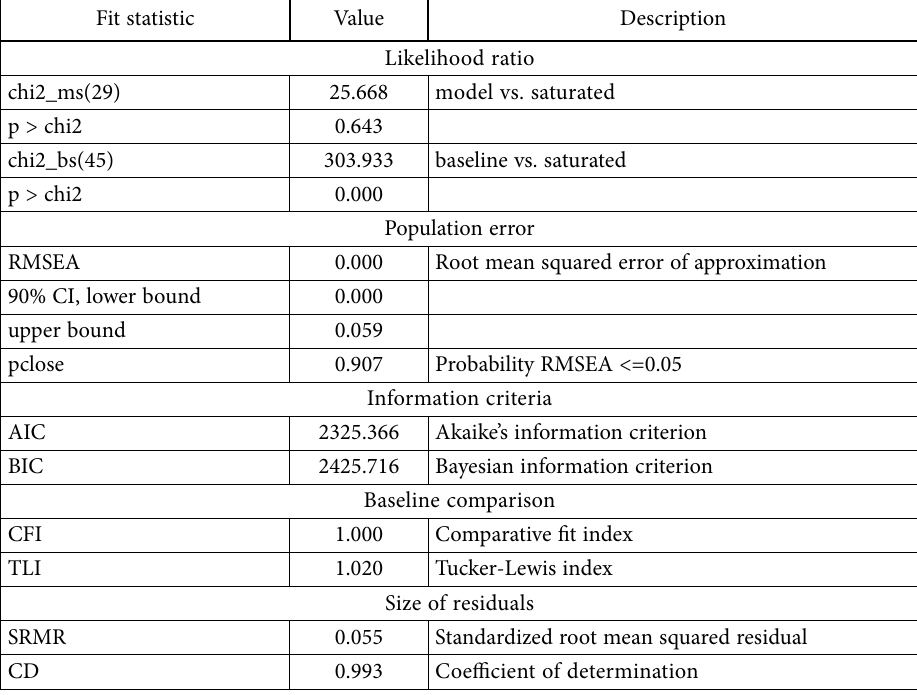
Table 4. Goodness of fit of the